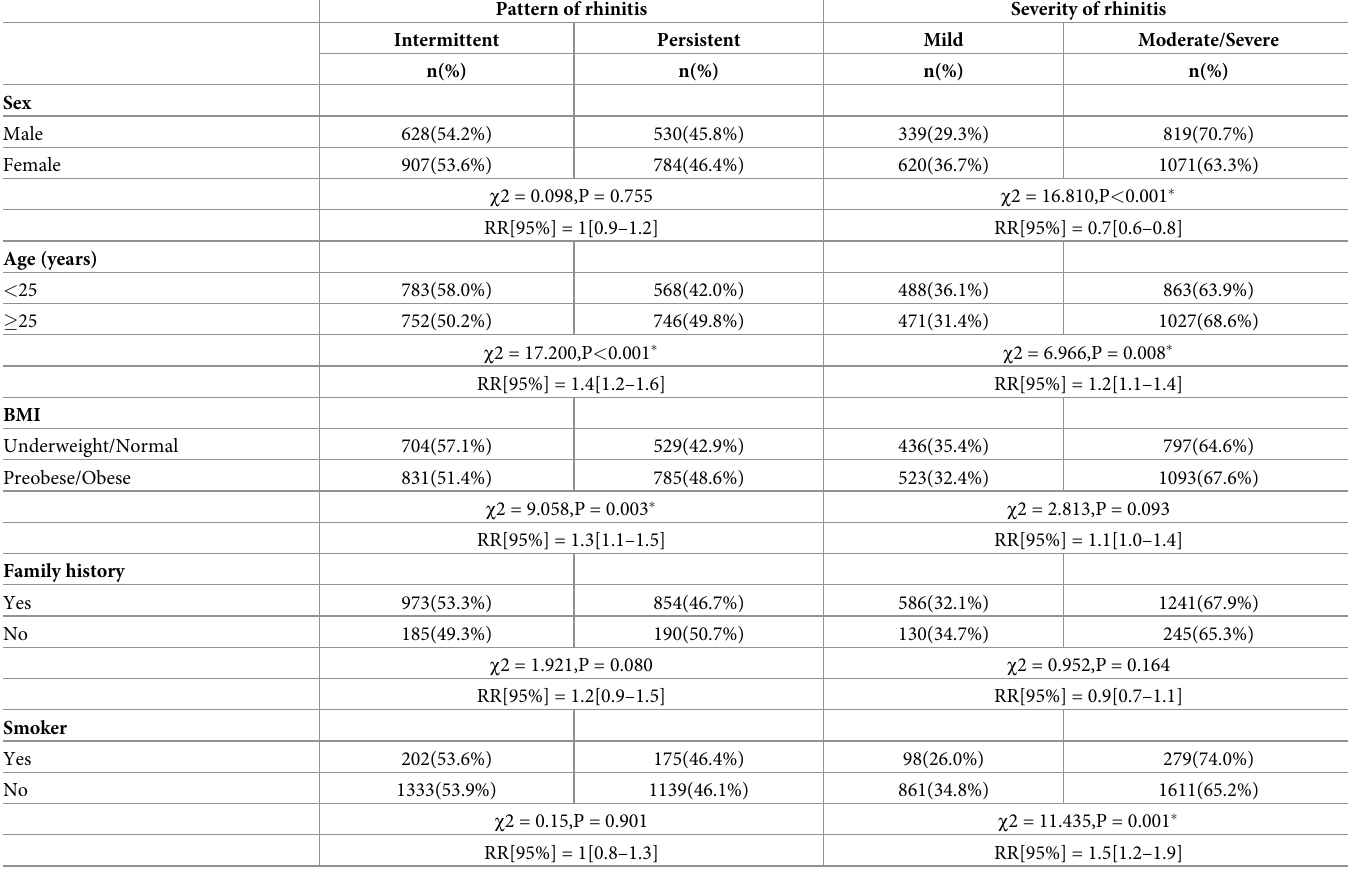
Table 4. Association between pattern and severity of allergic rhinitis with sample